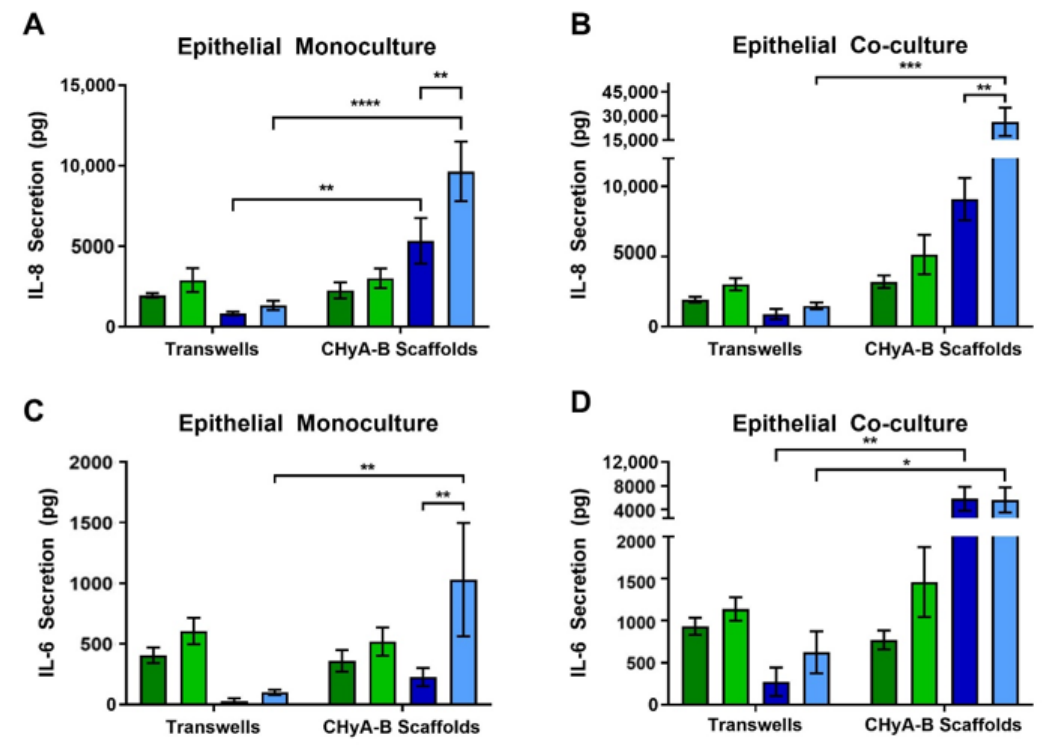
Figure 6. Pro-inflammatory cytokine release profile from epithelial cultures following drug-mediated challenge. Apical and basolateral IL-8 release from Calu-3 epithelial monocultures ( A ) and Calu-3 Wi38 co-cultures ( B ) on Transwell ® inserts and CHyA-B scaffolds following challenge with 100 µ g/mL of bleomycin for 24 h measured at day 23 in culture. Apical and basolateral IL-6 release from Calu-3 epithelial monocultures ( C ) and Calu-3 Wi38 co-cultures ( D ) on Transwell ® inserts and CHyA-B scaffolds following bleomycin exposure. Results displayed as mean ± SEM ( n = 3; * p < 0.05, ** p < 0.01, *** p < 0.001, **** p <